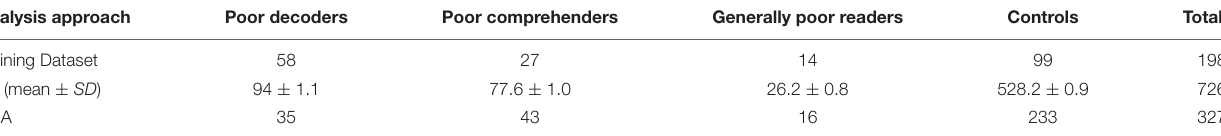
FIGURE 4 | Classification accuracy by reading profiles and missing variables. Classification accuracy for each reading profile decreased when missForest was used to impute values for the measure that differentiates a reading profile from the others. For example, classification accuracy decreased more when Verbal IQ was missing for the Generally Poor Readers compared to the other test scores. The x -axis in each plot indicates the simulated percent missingness in the synthetic dataset, while the y -axis indicates the reduction in classification accuracy for the imputed datasets relative to the original synthetic data with no missingness. Each point shows the average with SEM error bars calculated over 1,000 simulations. TABLE 1 | Participant counts for each profile based on multiply imputed test scores or observed